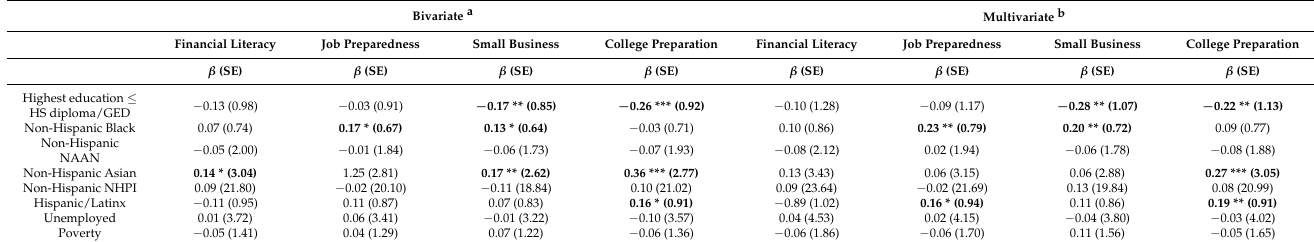
Table 3. Results of Bivariate Linear Regressions of the Relationship between Census Tract Demo- graphics and Economic Mobility Programs Offered at Libraries in Census